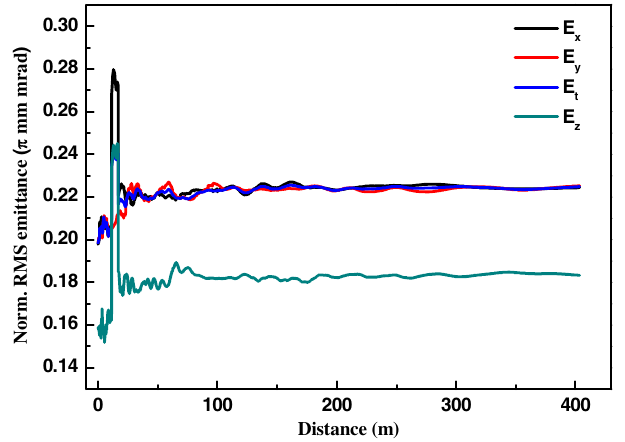
FIG. 26. Evolutions of the normalized rms emittances along the linac.